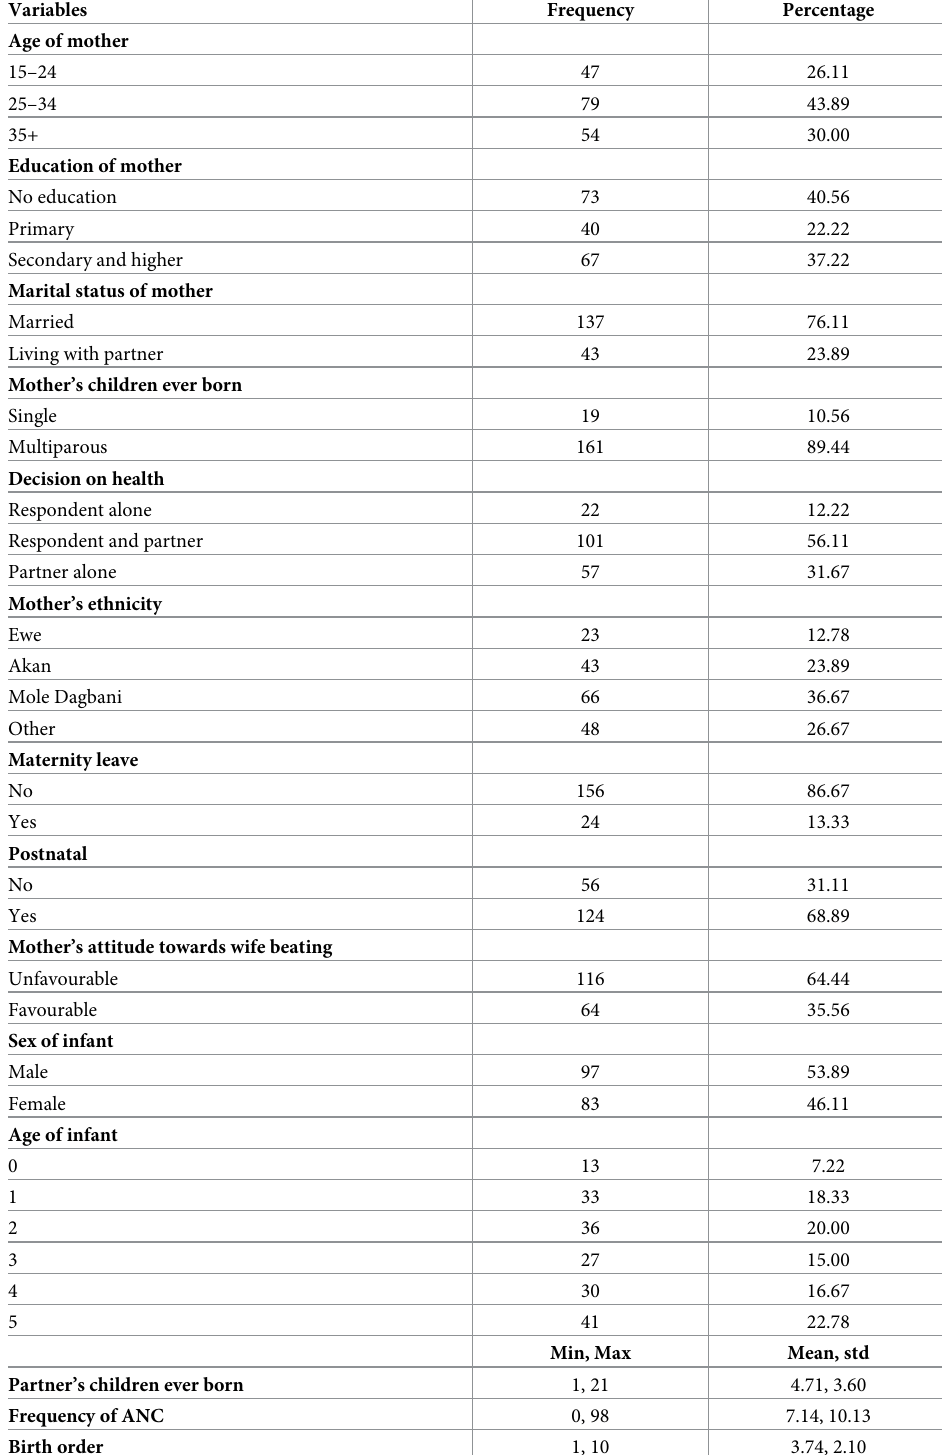
Table 2. Description of mother and infant